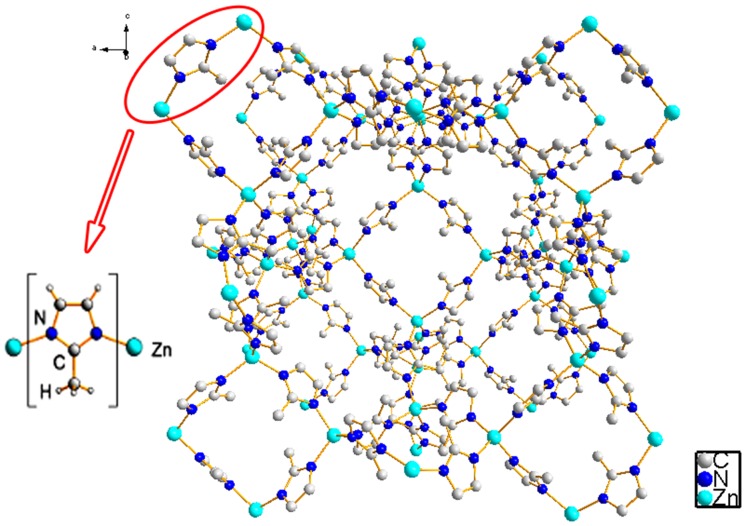
ZIF-8 structure.